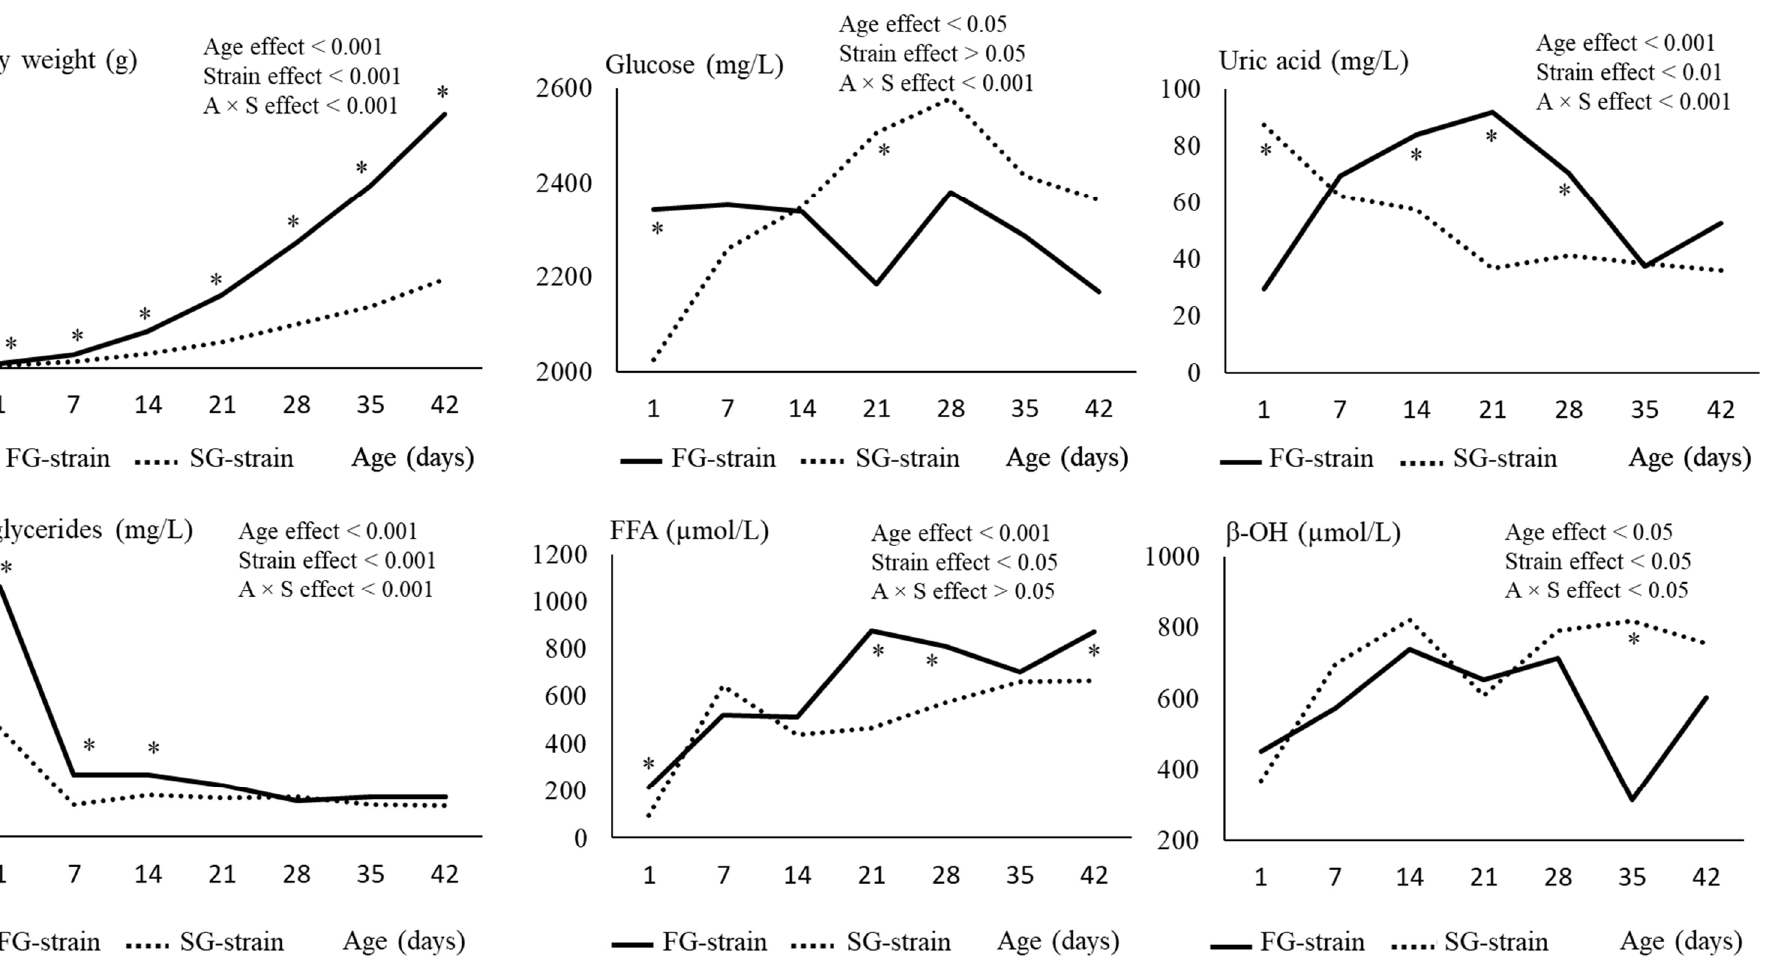
Figure 1. Effects of age (A) and strain (S) and their interaction on chicken body weight and plasma metabolite content. Data are presented as means; n = 10 per strain and per age. *: Significant difference ( p < 0.05) between strains for a given age; FG = fast-growing, SG = slow-growing.